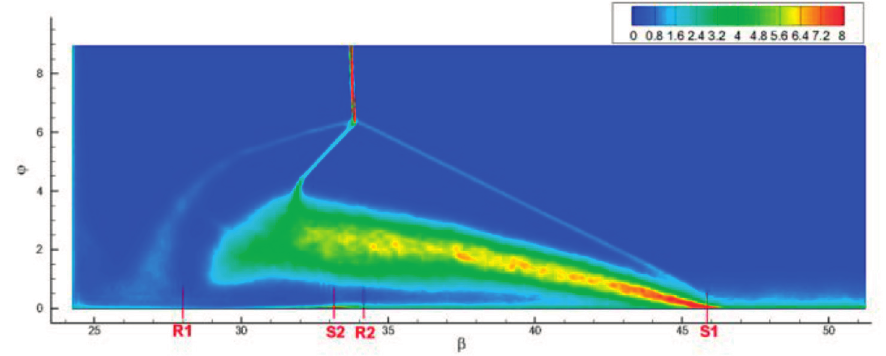
Figure 16. Development of stream surfaces originating at the inflow plate, at constant distance from the flat plate: ( a , b ) Data of Fang et al. [8]; ( c , d ) Data of Panaras [5].